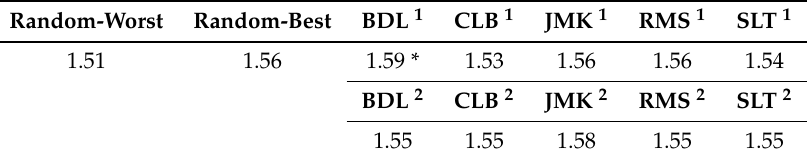
Table 5. Mean PESQ Results for JMK voice. Higher values represent better results.